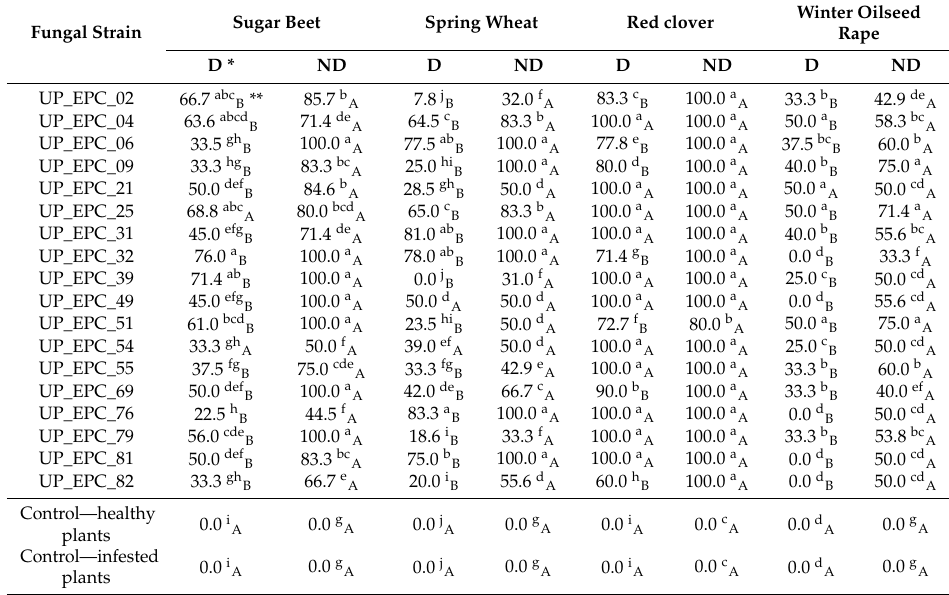
Table A6. The percentage of E. nigrum isolates in relation to all fungi re-isolated from infected seedlings of sugar beet ( B. vulgaris L. ssp. vulgaris ), spring wheat ( T. aestivum L.), red clover ( T. pratense L.), and winter oilseed rape ( B. napus